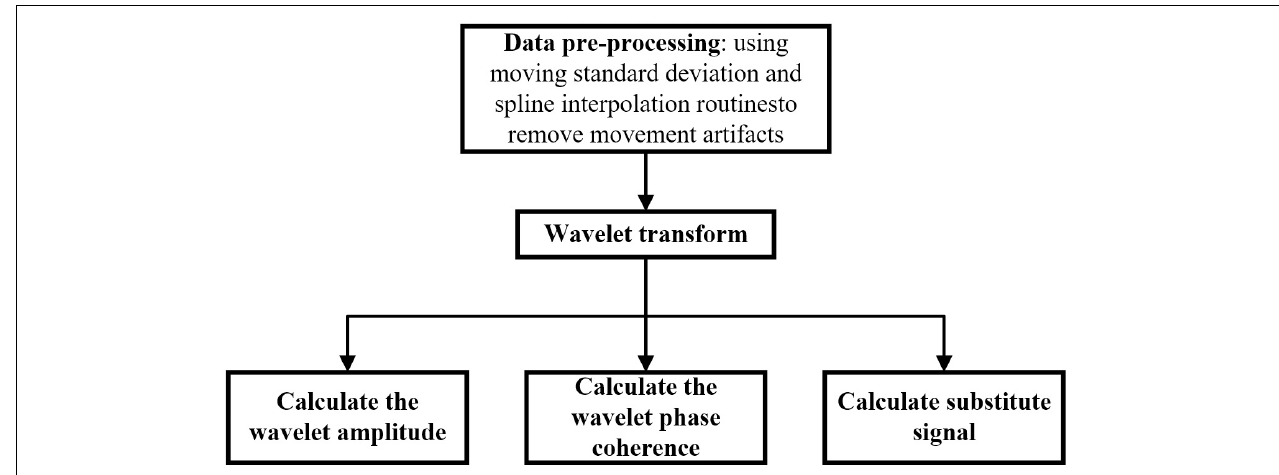
FIGURE 5 | Data processing process. First, pre-process the data of fNIRS, then calculate the wavelet transform, and finally calculate the wavelet amplitude, the wavelet phase coherence and substitute signal.